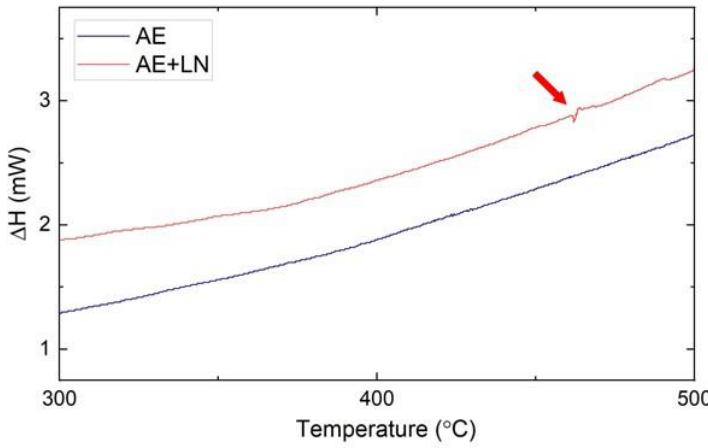
Figure 3. DSC results of samples with and without DCT.